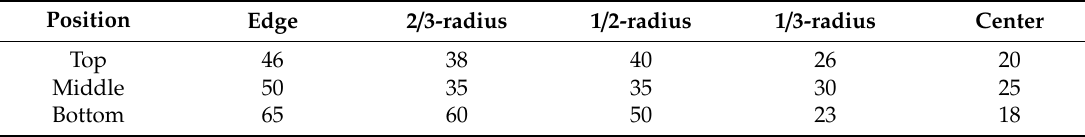
Table 3. Solidification front angle at di ff erent positions of the ESR ingot